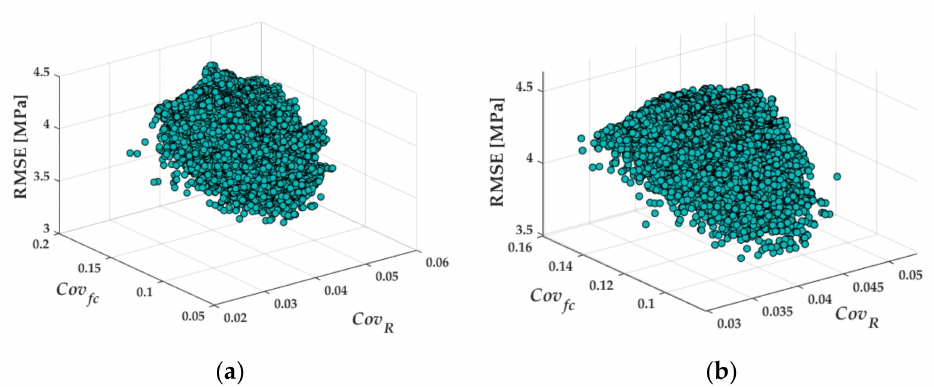
Figure 11. RMSE (Equation (10)) evaluated for the polynomial conversion models vs. coefficient of variation of the in-situ concrete strength Cov fc and coefficient of variation of the rebound index Cov R : ( a ) m = 15; ( b ) m =